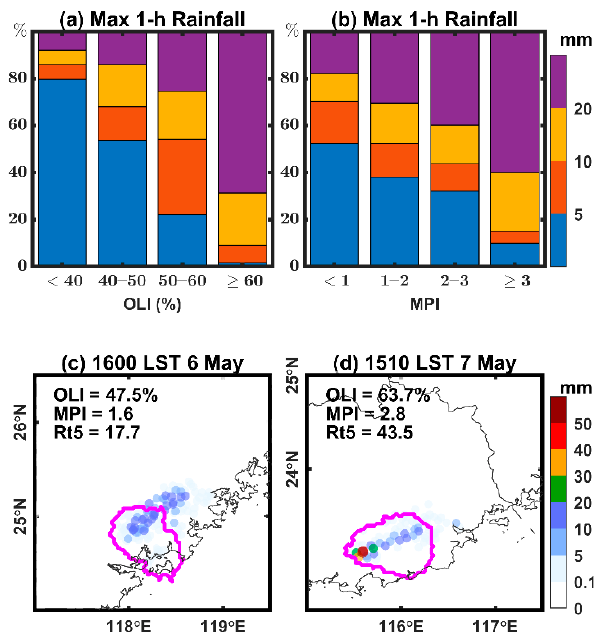
Figure 13. ( a , b ) Distribution of the maximum rainfall amount in the next hour produced by the MCS samples during EP1 and EP2, as a function of ( a ) OLI and ( b ) MPI, respectively. The maximum rainfall amount in the next hour is calculated as the average of the top five hourly rainfalls belonging to an MCS sample. ( c , d ) Two MCS samples (outlined in magenta) with relatively low and high OLI/MPI values, which produced relatively weak and strong maximum rainfall amount in the next hour. See Section 4.3 for more details.